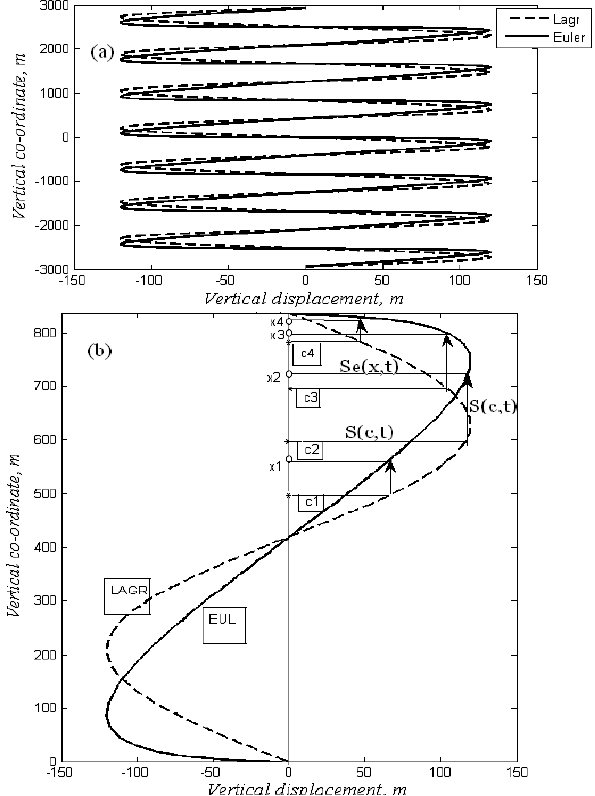
Fig. 6. Vertical profiles of the vertical displacement field of ducted gravity mode in Lagrangian (dotted line) and Eulerian (continu- ous line) frames, M =0.9; (a) distortion of the profile S E,z (z,t 0 ) ; (b) fragment of S E,z (z,t 0 ) illustrating the distortion of the profile due to displacements S c (c,t 0 ) of the selected four equidistant fluid parcels with the Lagrangian co-ordinates c 1 ,c 2 ,c 3 ,c 4